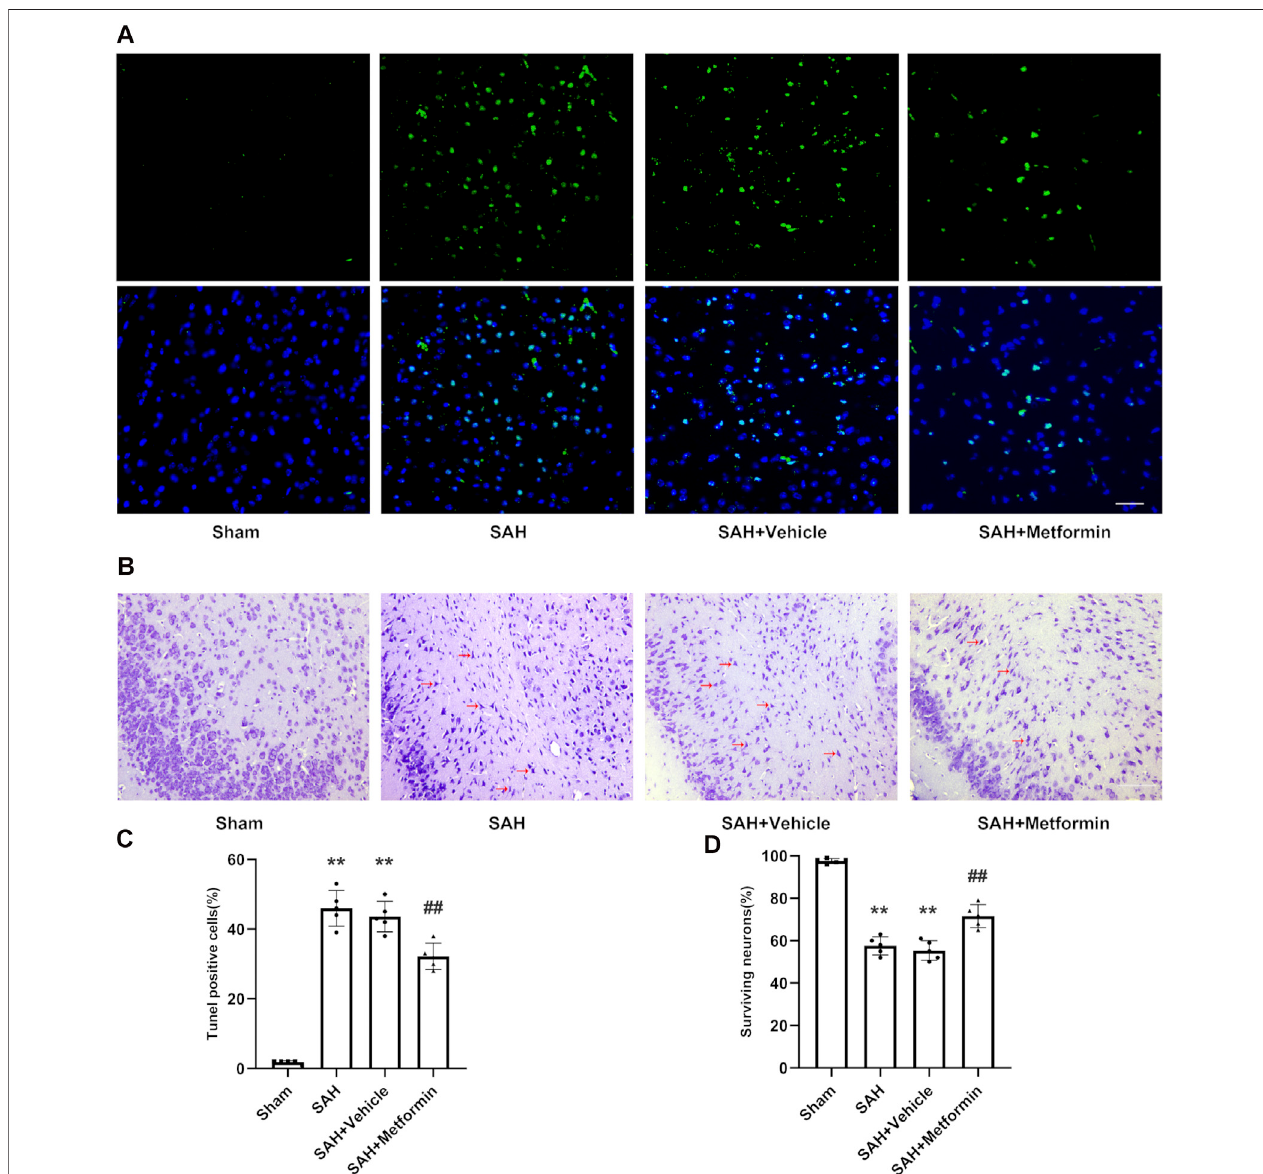
FIGURE5| MetformininhibitscellapoptosisandpromotesneuronsurvivalinthecortexafterSAH.Abbreviation:Met=metformin. (A) Typicalphotomicrographsof TUNEL staining (Magni fi cation = ×400, scale bar = 50 um, n = 5 per group). (C) Quantitative analysis of TUNEL staining. (B) Representative photomicrographs of Nissl staining. Compared to normal neurons, impaired neurons show shrunken cell body and staining darker nuclei. The representative form of the impaired neurons was markedwithared arrow (Magni fi cation=×200,scalebar =100um, n =5per group). (D) ThequantitativeanalysisofNissl staining.Dataareshown asmean±SD. ** p < 0.01 vs. sham group. ## p < 0.01 vs. SAH + Vehicle (normal saline) group.